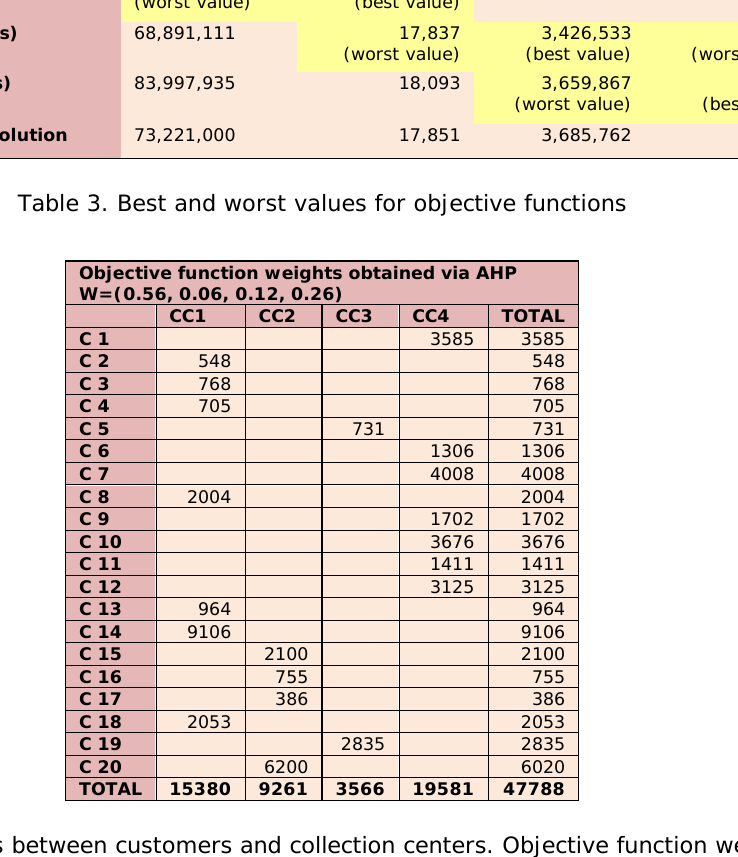
Table 4. Flows between customers and collection centers. Objective function weights obtained via AHP